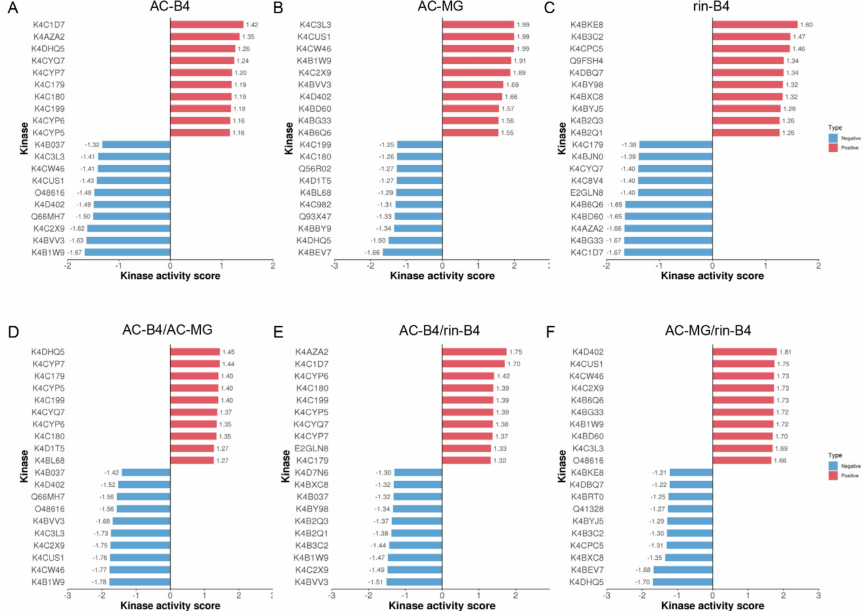
Figure 8. Analysis of phosphokinase activity in different samples and comparison groups. ( A ) AC-B4; ( B ) AC-MG; ( C ) rin-B4; ( D ) AC-B4/AC-MG; ( E ) AC-B4/rin-B4; ( F ) AC-MG/rin-B4. The x -axis is the phosphokinase activity score, and the y -axis holds the phosphokinases with the top-10 active- or inhibited-state activity scores. Red represents the activated state, and blue represents the inhibited state. The NES (normalized enrichment score) value obtained by the enrichment analysis is as the kinase activity score. If the kinase activity score is more than 1, the kinase tends to be activated; If the kinase activity score is less than 1, the kinase tends to be inhibited. The ratio threshold of the differential expression change ratio is 1.5, and the difference significance p value threshold is